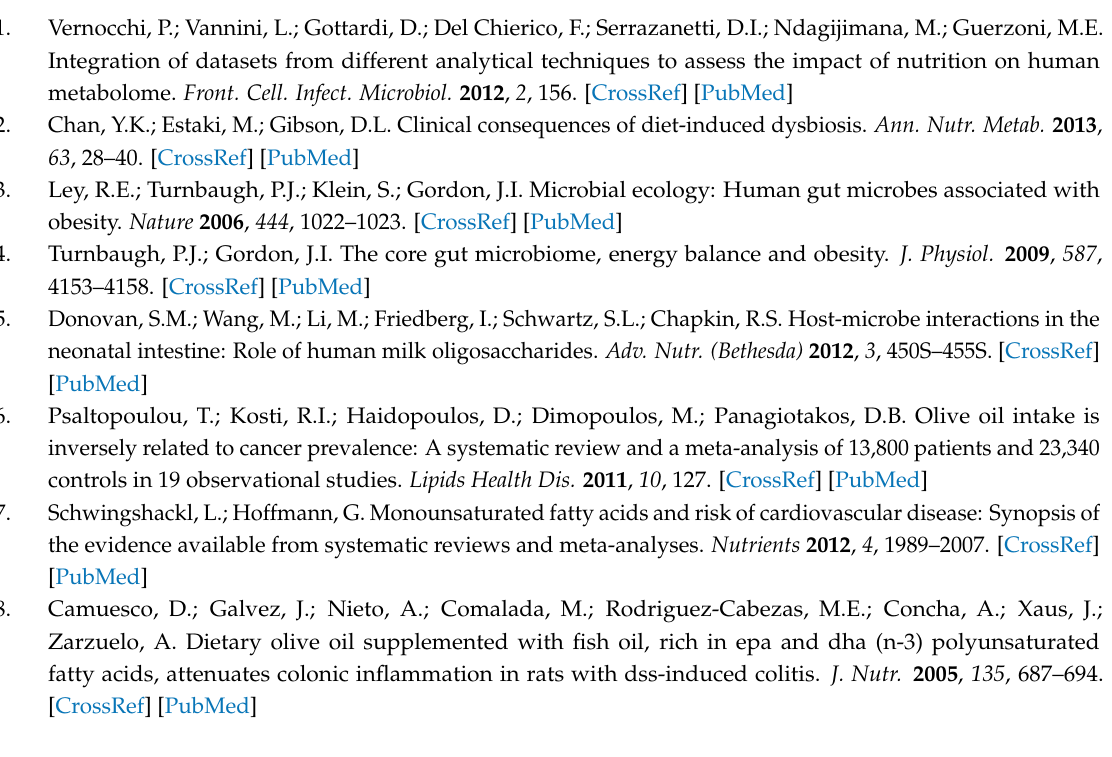
Figure S1: Mouse Weights, Figure S2: Spearman rank correlation depicting correlations between selected host proteins and mucosal phyla, Table S1: All bacterial mucosal proteins identified by 1 or more peptides; Table S2: All bacterial submucosal proteins identified by 1 or more peptides; Table S3: All host submucosal proteins identified by 4 or more peptides; TabS4: All host mucosal proteins identified by 4 or more peptides; TableS5: All matching host mucosal and submucosal proteins identified by 4 or more